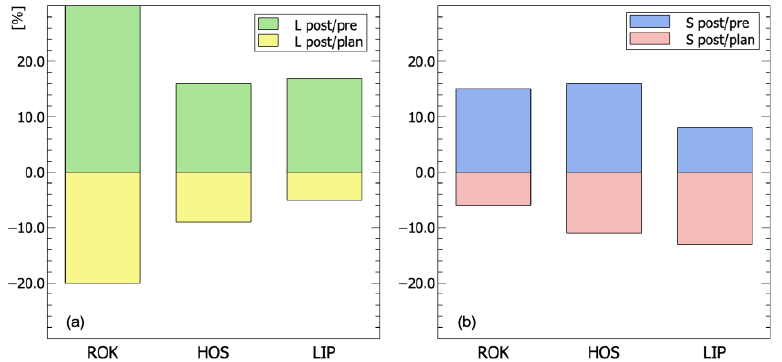
Figure 4. The relative difference in the ( a ) stream length and ( b ) sinuosity of the assessed streams. When assessing the stream geometry in individual stream reaches, there are even realized restorations mostly fit the plans (Table A1). In contrast, in the central parts of the restored streams, the channel route is formed relatively freely, with significant deviations in geometric parameters but also in the channel route from the approved plans (Figure 5). In all the realized restorations, the new channels substantially deviated from the planned route, with meanders built in the opposite direction compared to the plan. Most new meanders were built in different locations with different sizes and amplitudes. The same situation applies to the newly built ponds, which are chiefly constructed in different locations.